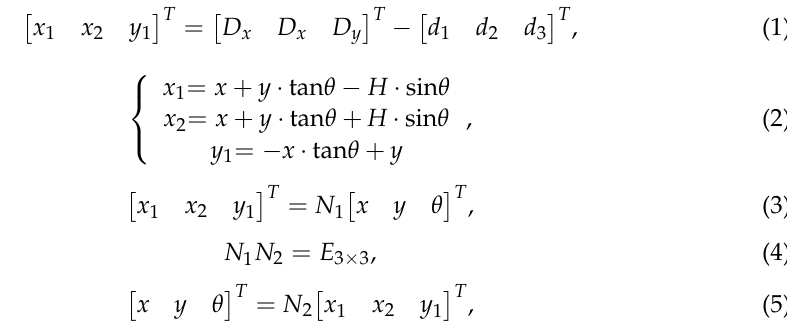
Figure 4. Relationship between the working air gap and sensor measurement distance.